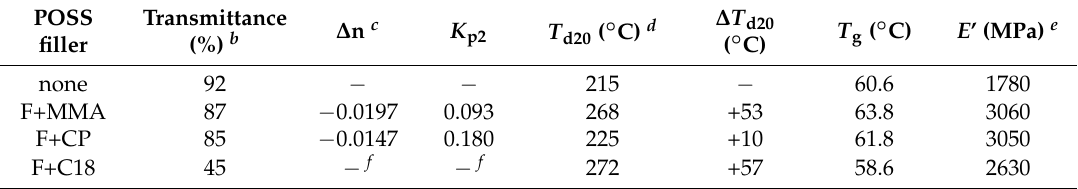
Table 1. Summary of the filler effects on the various properties of the PMMA, by the POSS fillers a .